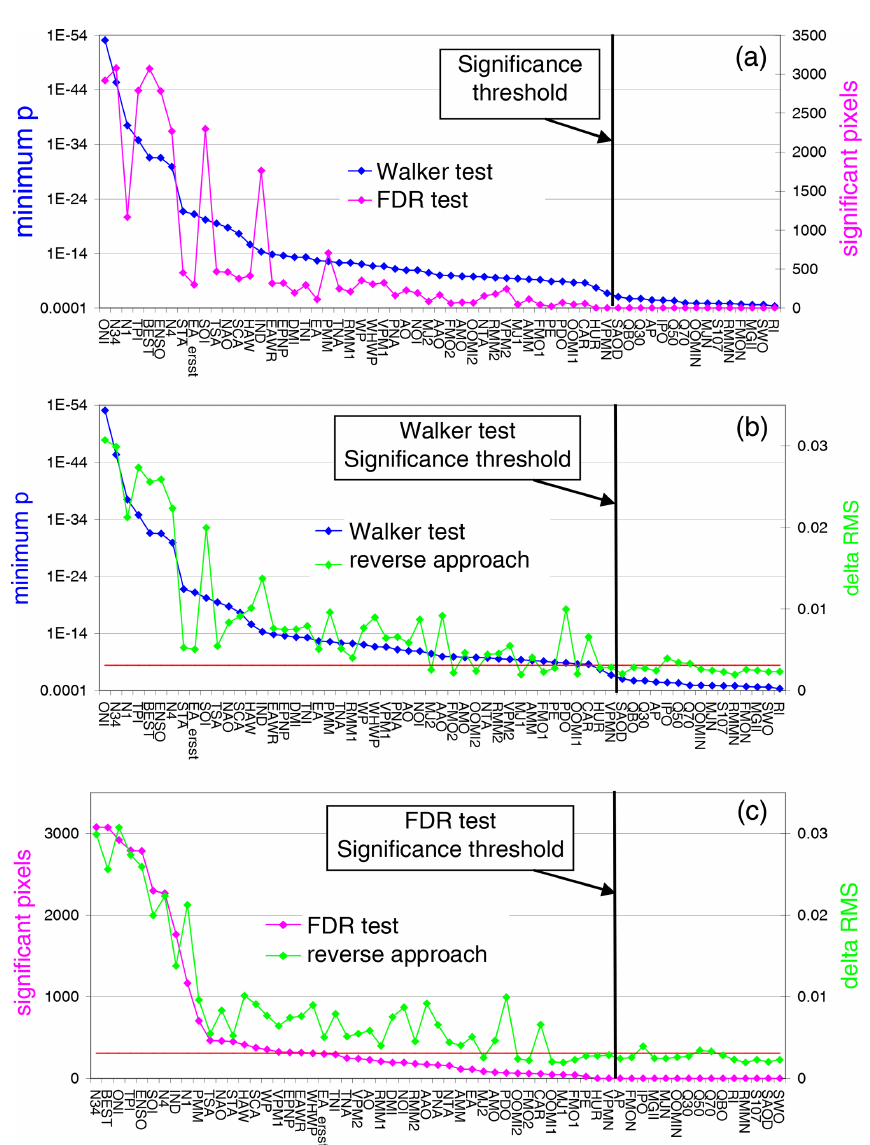
Figure 8. Comparison of the results of the three approaches. (a) Results for the Walker test (left axis) and FDR test (right axis) for a significance level of 1%. The indices are sorted according to the results of the Walker test. The black vertical line indicates the significance threshold (similar for both tests). (b) Comparison of the results for the Walker test (left axis) and our empirical (reverse) approach (right axis). The indices are sorted according to the results of the Walker test. The black vertical line indicates the significance threshold of the Walker test. The red horizontal line indicates the significance threshold for our empirical approach. (c) Similar as for the middle panel, but for the FDR